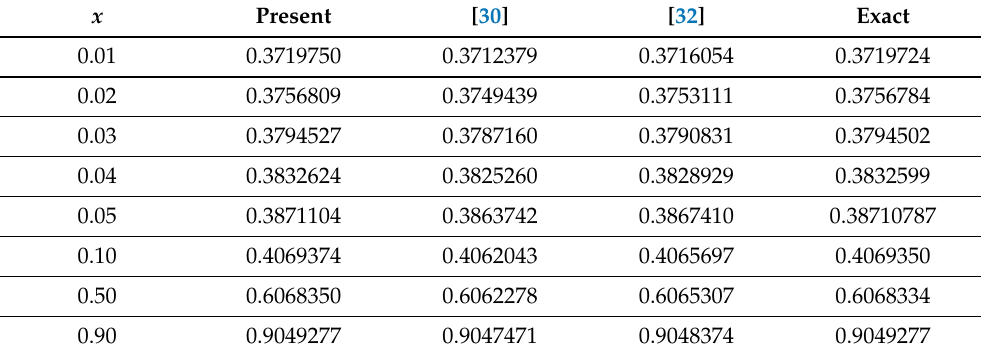
Figure 2. For example 1, comparing the exact solution, a uniform approximation, the present asymptotic-numerical solution and the IVPM solution. Table 2. For example 2 with ε = 0.001, comparing the numerical solutions at different x with an exact solution and other solutions. x Present [30] [32]